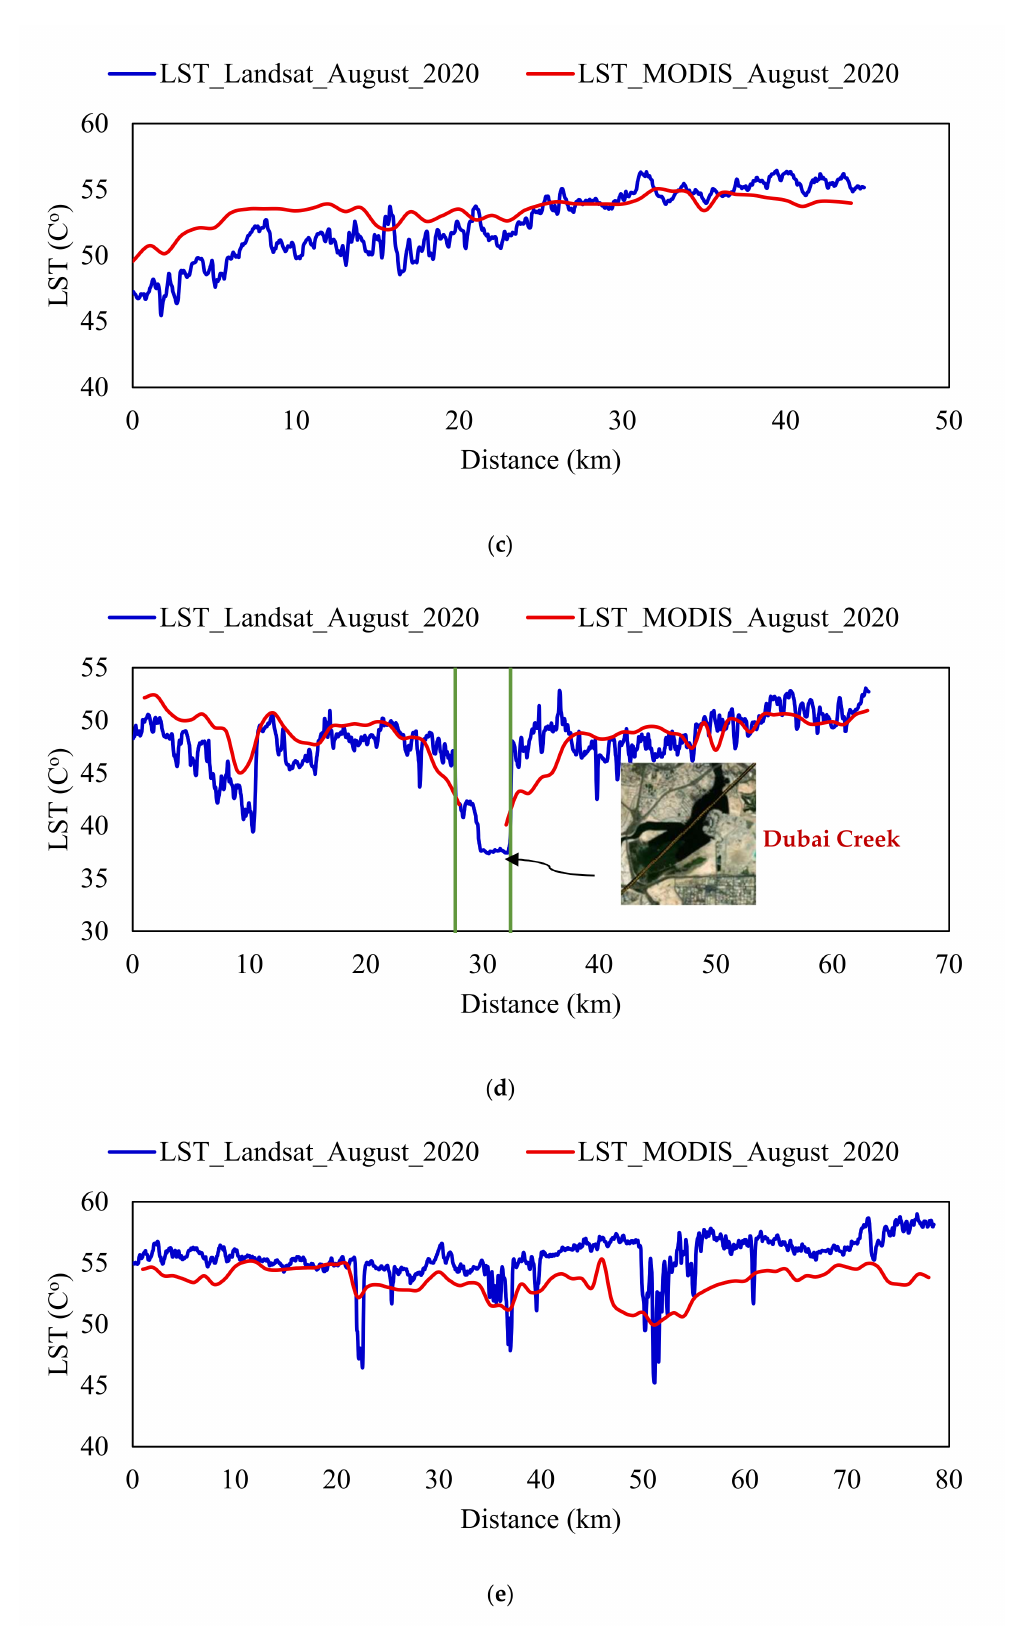
Figure 14. Spatial Profiling of Daytime LST in Summer Season. ( a ) Profile 1; ( b ) Profile 2; ( c ) Profile 3; ( d ) Profile 4; ( e ) Profile